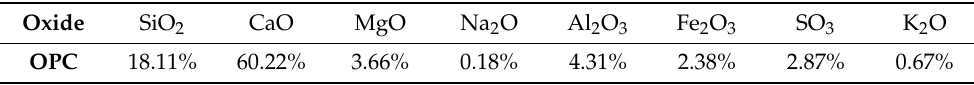
Table 1. Chemical composition of cement.